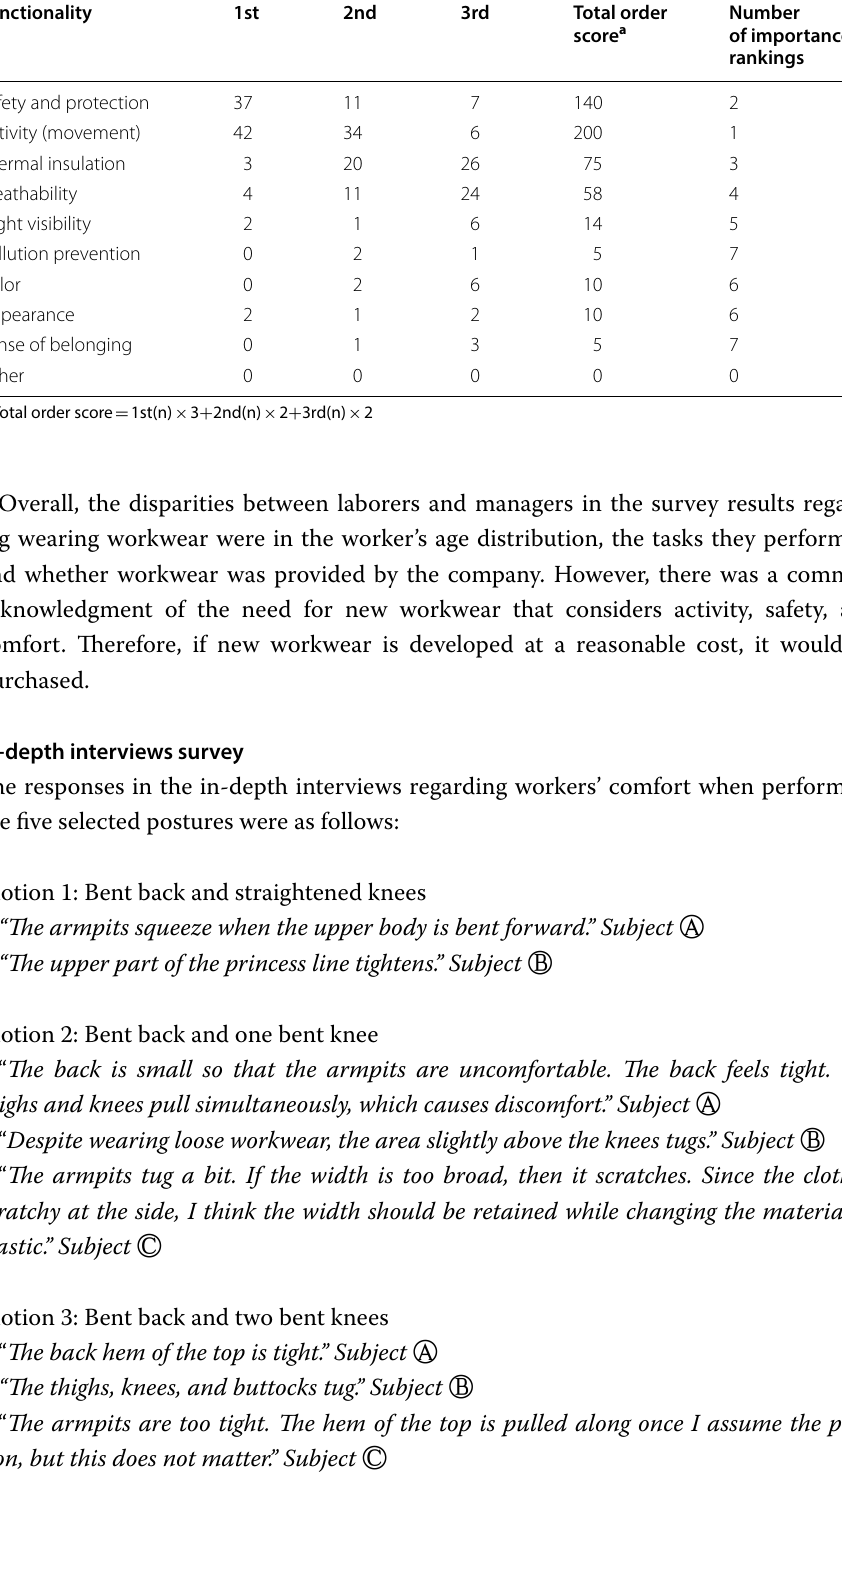
Table 11 Important functionalities in workwear (Unit: n,